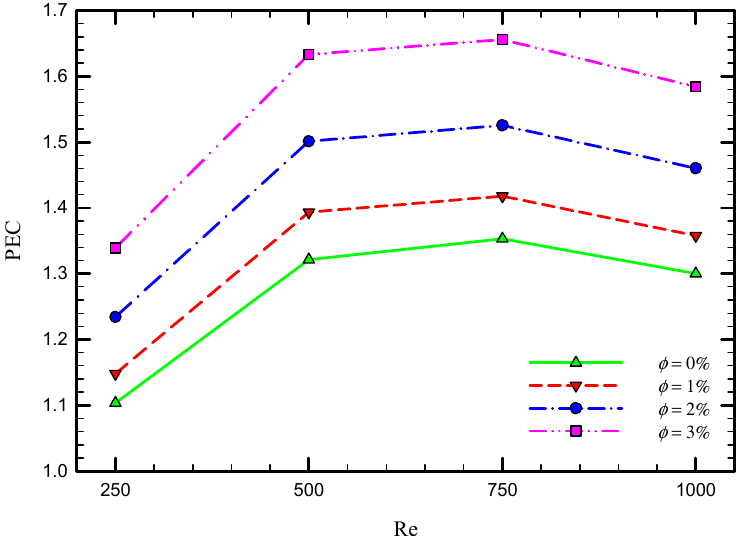
Figure 17. Variation of PEC with Re for Case 5 at different nanofluid volume concentrations.